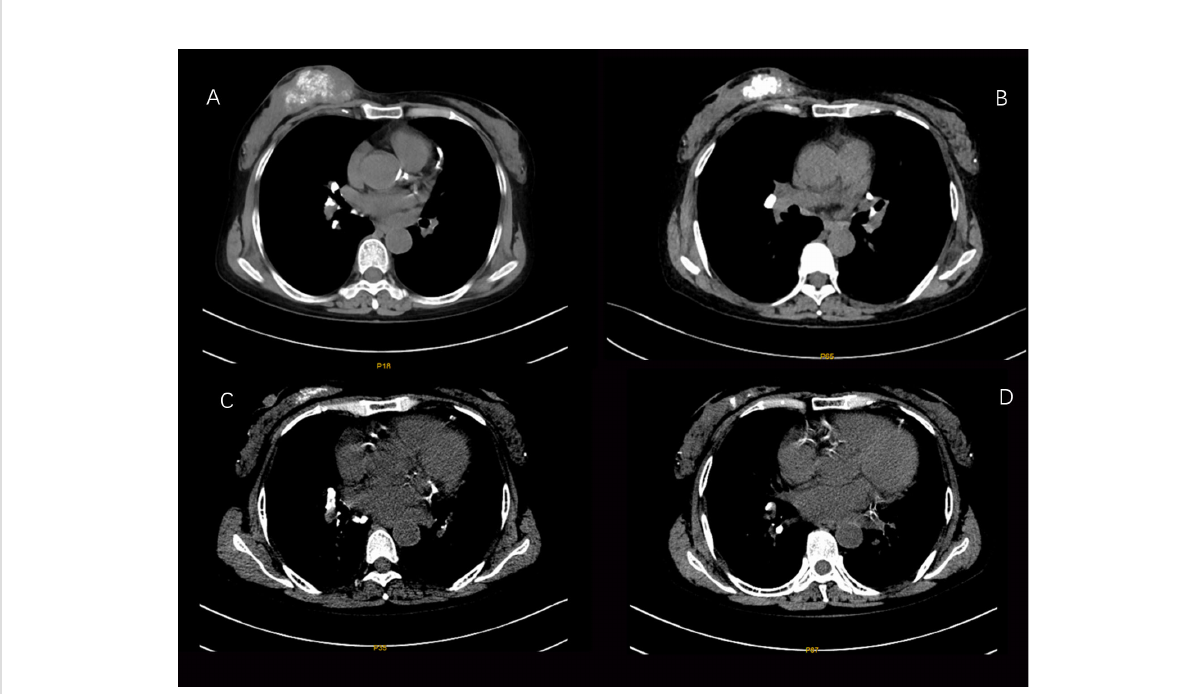
FIGURE 2 CT images of changes in breast tumor lesions in patients during the treatment period from August 6, 2021 to February 25, 2022 ( A :2021-08-06 B :2021-09-25 C :2021-12-17 D : 2021-02-25).